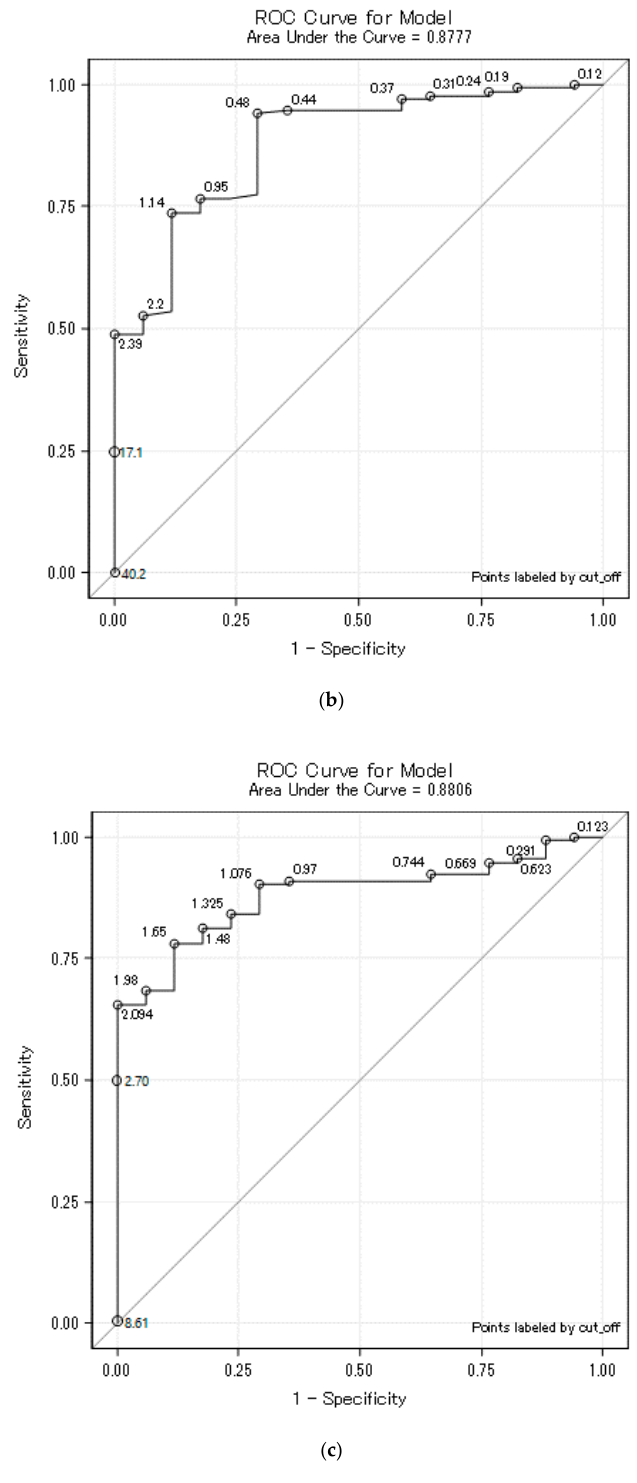
Figure 3. ( a ) Diasorin cut-off for titer 80. ( b ) Beckman Coulter cut-off for titer 80. ( c ) Euroimmun cut-off for titer 80. Legend: ROC curve for Diasorin, Beckman Coulter and Euroimmun, titer <80 vs. ≥ 80 where the ROC curve is labeled by all possible cut-offs. These ROC curves are atypical, and, above all, their vertical parts increase at the point of 100% specificity, demonstrating that it was not targeted at 100% specificity, but 95%. For some methodologies, however, it accidentally led to 100% specificity. For cut-off values for individual methods, see Table